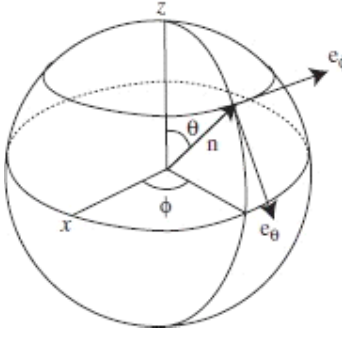
Figure 6. Vector analysis of angle quantities of e θ , e φ and the unit moment parameter n .